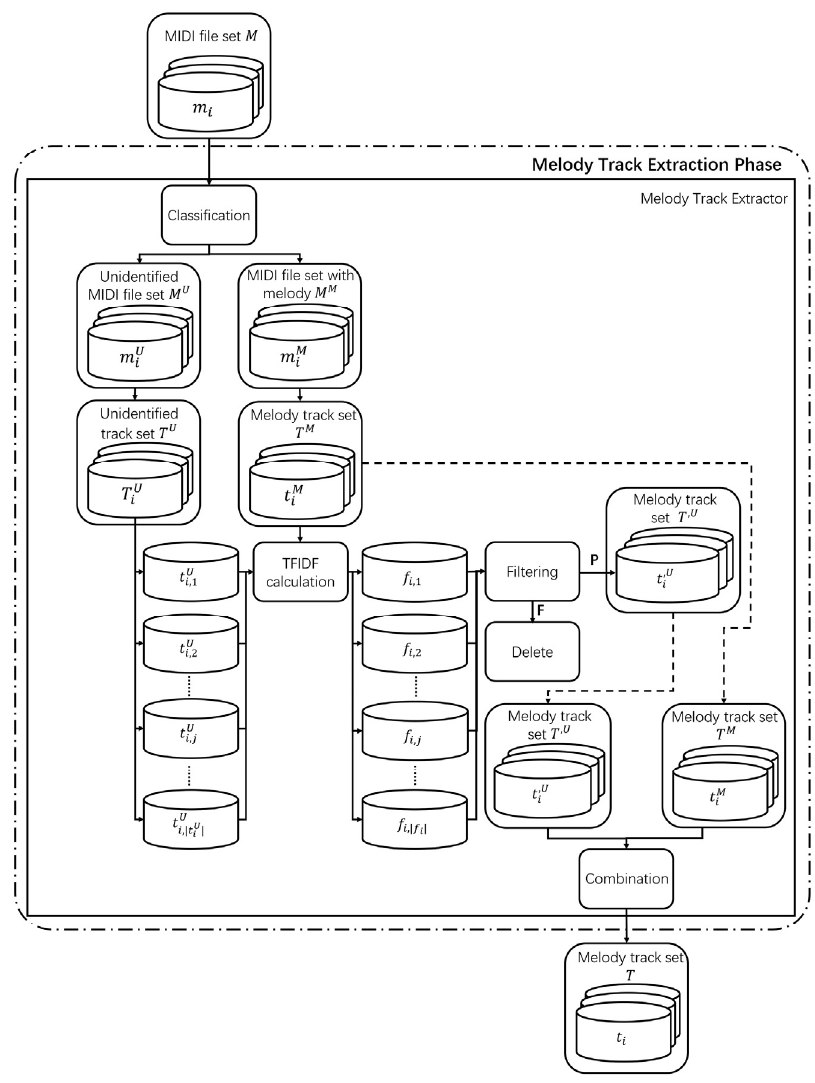
Figure 2. Melody track extraction process.